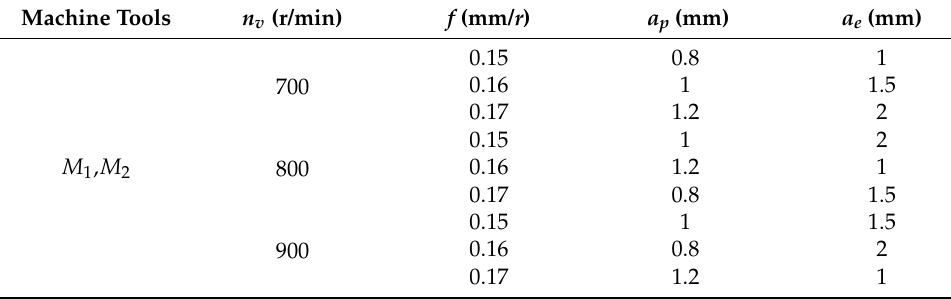
Table 3. Experimental cutting parameters